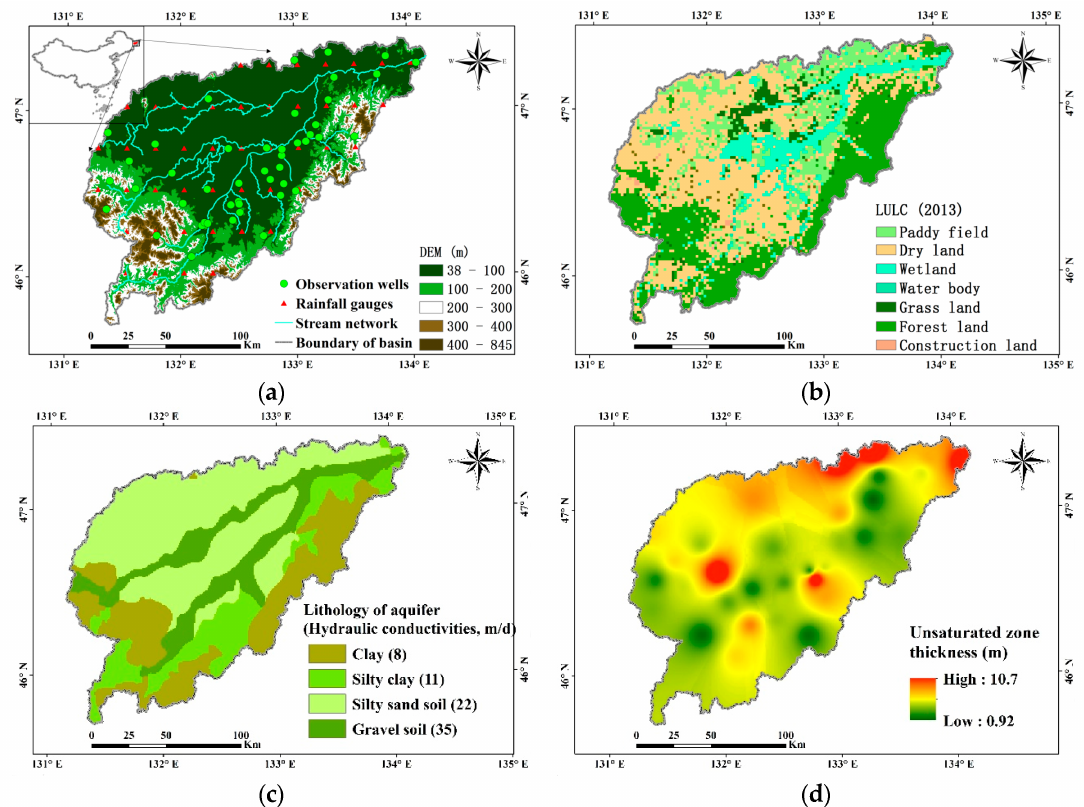
Figure 1. ( a ) Geographical locations of the observational wells and precipitation gauge stations used in this study; ( b ) Land use and land cover (LULC); ( c ) hydraulic conductivities; and ( d ) average unsaturated zone thickness in the Naoli River basin, Northeast